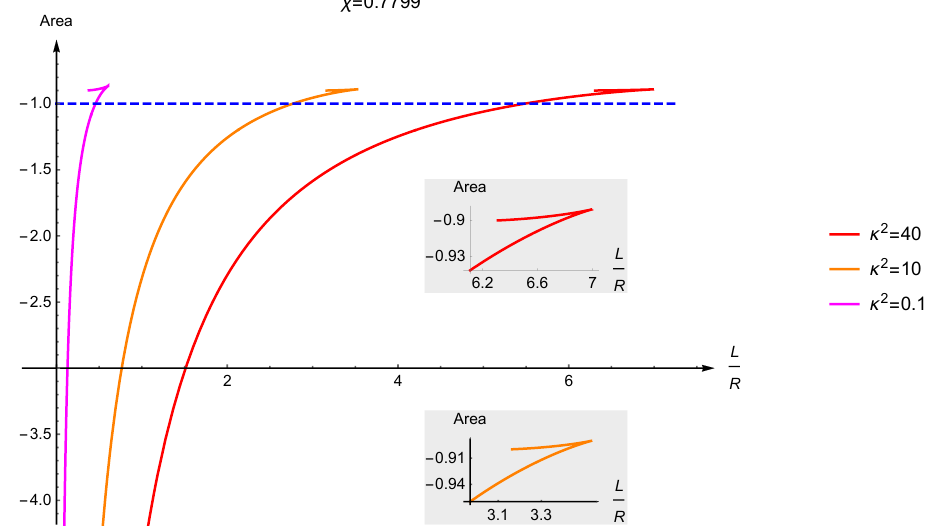
Figure 12. This plot displays the behavior of the area as a function of the distance L=R for a (cid:12)xed value of the angle (cid:31) = 0 : 7799 > (cid:31) s . In this range there is no critical (cid:13)ux. The typical behavior is described by the three curves (red, orange and purple). There are always two branches of